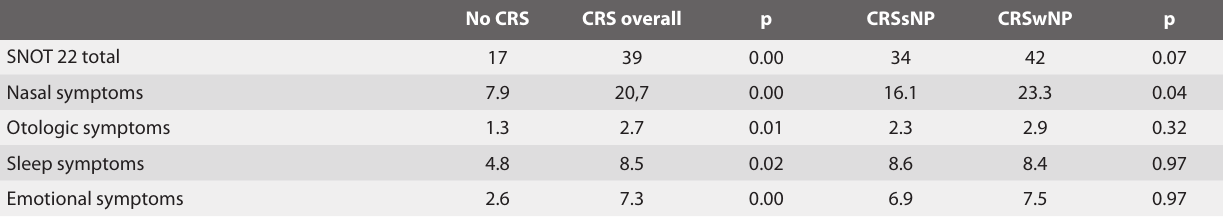
* Only septumplasty. Table 3. Mean score SNOT 22 total and mean score SNOT 22